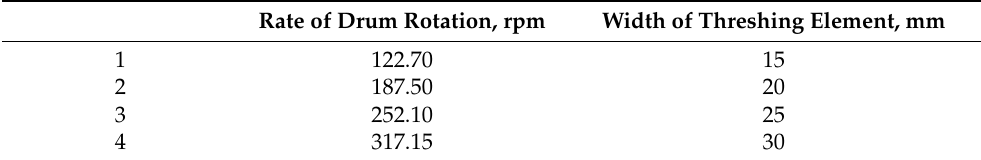
Table 1. Factors and levels of the simulation analysis.